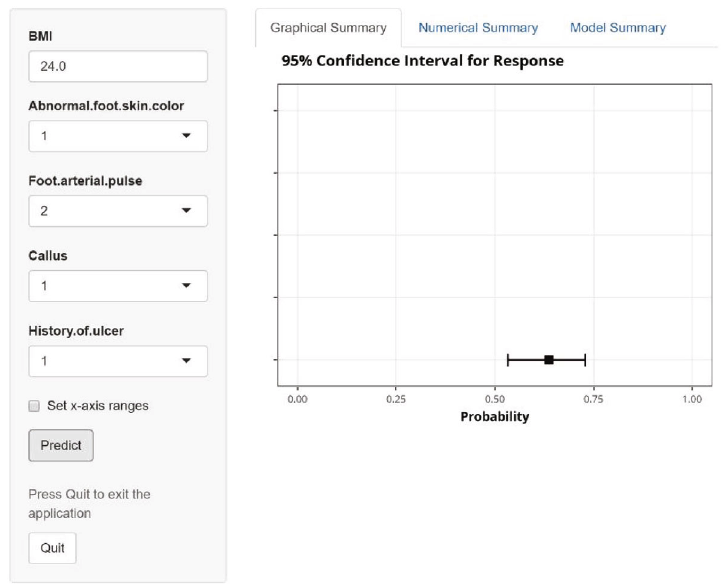
Figure 3: Web calculator for predicting foot ulcer risk in diabetic patients.